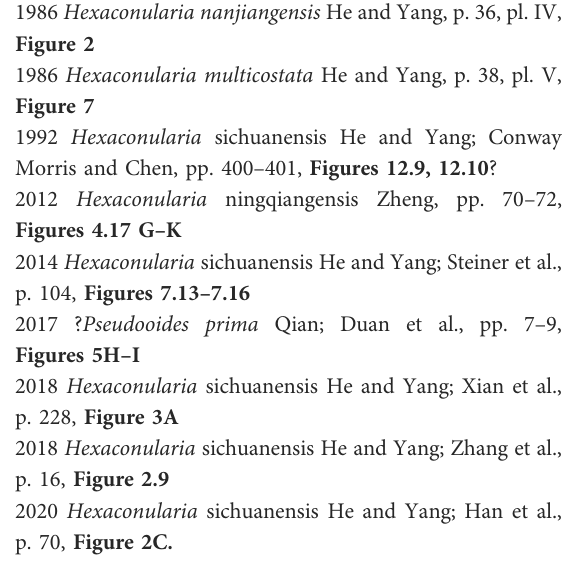
1986 Hexaconularia nanjiangensis He and Yang, p. 36, pl. IV,